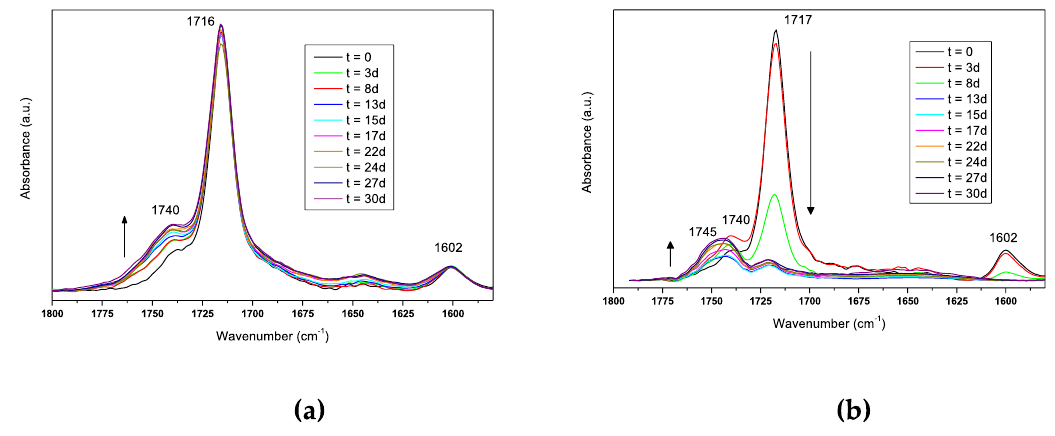
Figure 6. FT-IR spectra of EOC- g -(BHB-T)_2 ( a ) and EOC/(BHB-T)_2 ( b ) collected during the thermo-oxidation process. The spectra were normalized to the band at 720 cm −1 (methylene rocking).